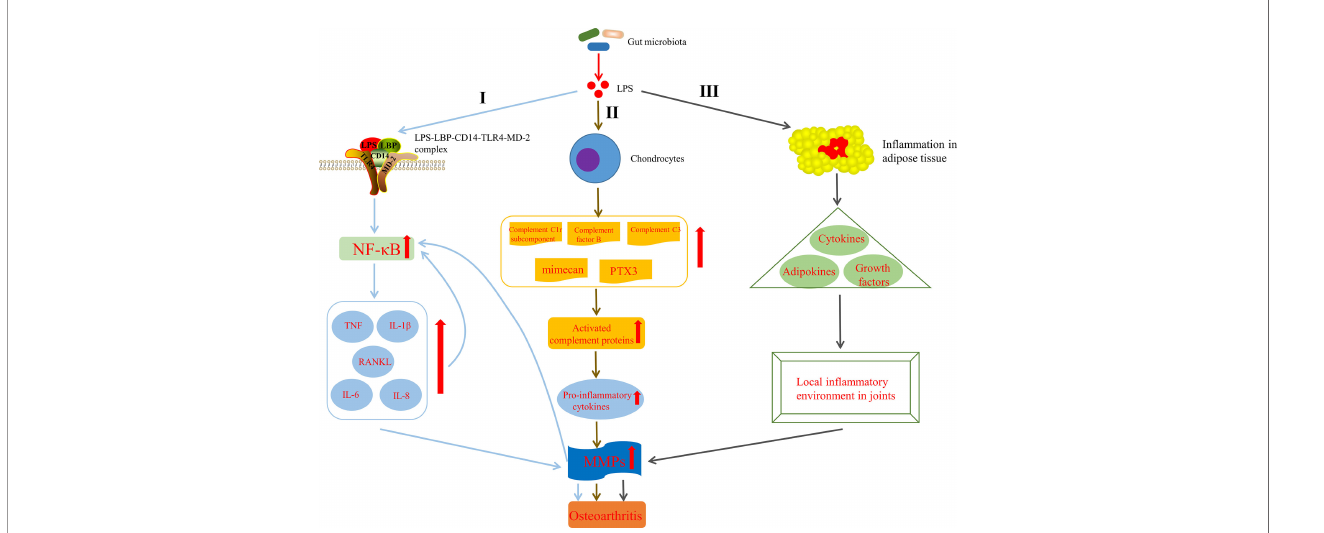
FIGURE 4 | Mechanisms by which lipopolysaccharide (LPS) affects the development of OA. I LPS is involved in OA by activating innate immune response via the formation of the LPS – LBP – CD14 – TLR4 – MD-2 complex, increasing NF- k B levels, up regulating TNF, IL-1 b , IL-6, IL-8 and RANKL levels, raising the production of MMPs and further reinforcing NF- k B activation. II LPS is involved in OA by activating complement pathway in chondrocytes (Haglund et al., 2008). III LPS is involved in OA by inducing in fl ammation in adipose tissue, precipitated systemic changes in cytokines, adipokines and growth factors, and fi nally affecting the local in fl ammatory environment inside the knee joint (Bleau et al., 2015). LPS, lipopolysaccharide; LBP, LPS binding protein; MD-2, myeloid differentiation protein-2; NF- k B, nuclear factor kappa-light-chain-enhancer of activated B cells; TNF, tumor necrosis factor; IL-1 b , interleukin-1-beta; RANKL, receptor activator of NF- k B ligand; PTX3, long pentraxin 3; MMPs, matrix